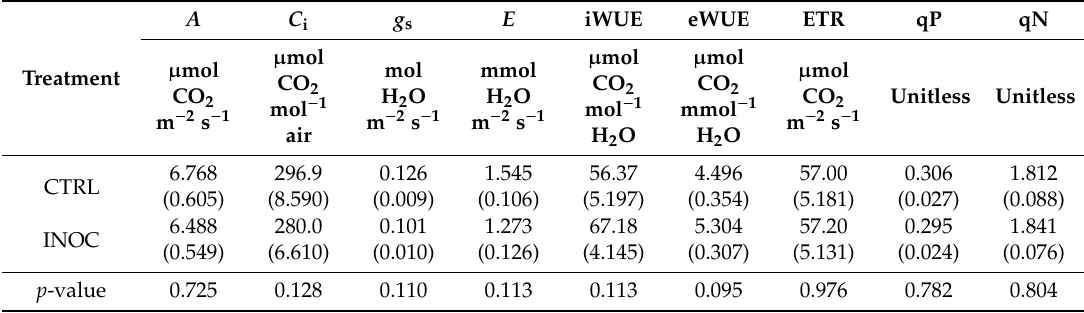
Figure 2. CO 2 response curves of the apple tree leaves: Photosynthetic net CO 2 assimilation rates ( A ) are plotted over a range of intercellular CO 2 concentrations ( C i ) of the leaves. Points indicate the means of the replicated samples at each pair of A / C i from each treatment group ( n = 15, CTRL and INOC for mock-inoculated control and endophyte-inoculated groups, respectively). Error bars represent the standard errors of the means. Lines indicate the values corresponding to the responses under the ambient CO 2 conditions (circa 400 ppm). Table 2. Descriptive and inferential statistics of leaf physiological trait parameters 1 at the ambient CO 2 level from the CO 2 response curves (Figure 2): The means of responses are provided with the standard errors of the means in parentheses (CTRL, mock-inoculated control; INOC, endophyte-inoculated; n = 15). p -values of an unpaired two sample t -test results on each parameter are